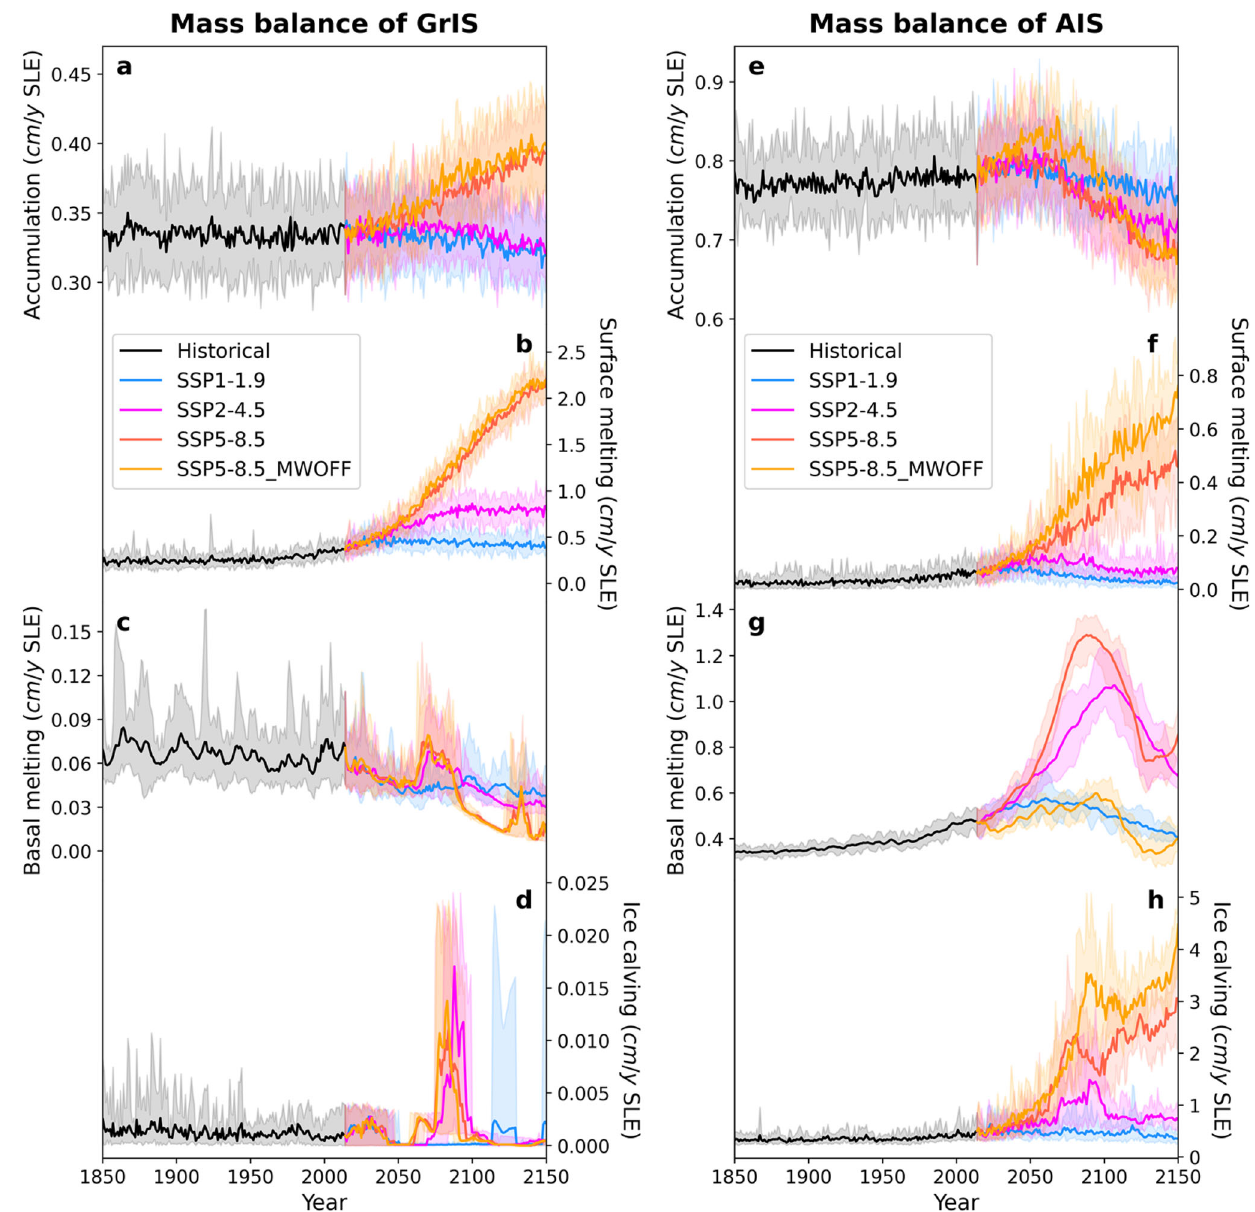
Fig. 4 | Individual mass balance terms for Greenland ice-sheet (GrIS) and Ant- arcticice-sheet(AIS).a – d RepresenttheindividualGrISmassbalancetermsfor( a ) the accumulation, ( b ) surface melting, ( c ) basal melting and ( d ) ice calving expressedassea-level-equivalent(SLE)peryear; e – h sameas a – d ,butforAIS.Solid